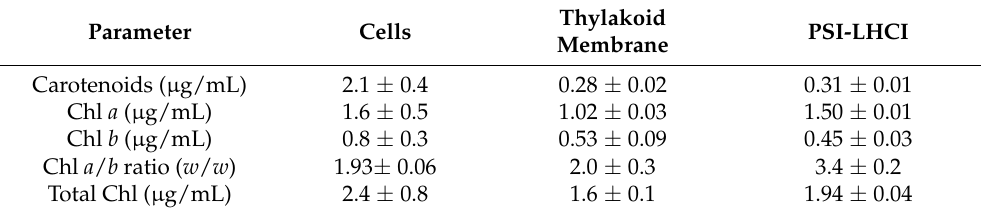
Table 1. Pigment content of B. braunii cells, thylakoid membrane, and PSI-LHCI complex extracted in 90%